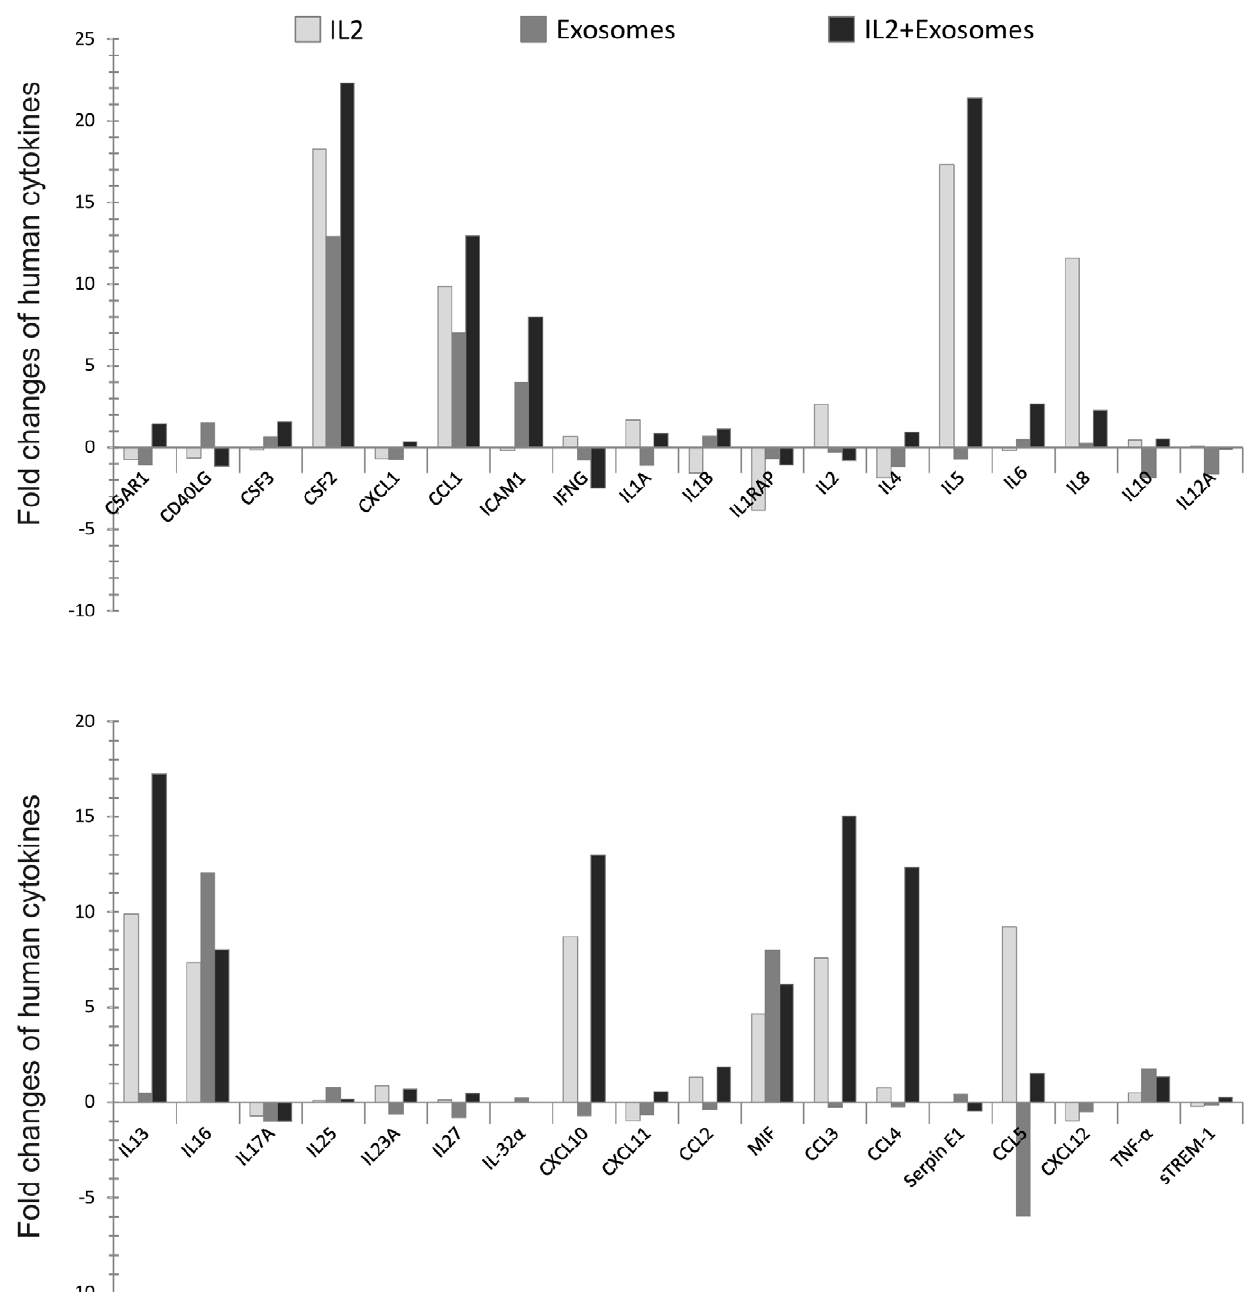
Figure 4. A comparison of cytokines and chemokines present in the supernatant of CD3 + T cells pulsed with IL-2, exosomes or IL- 2 + exosomes. Fold changes in the production of cytokines, chemokines and other proteins after five days. T cells stimulated with IL-2 or exosomes had different expression of cytokines and chemokines. Samples stimulated with ‘‘exosomes + IL-2 0 generated secretion of more cytokines and chemokines compared to samples stimulated with either IL-2 or exosomes alone. A significant decrease could be noticed for CCL5 in cultures stimulated with exosomes only.